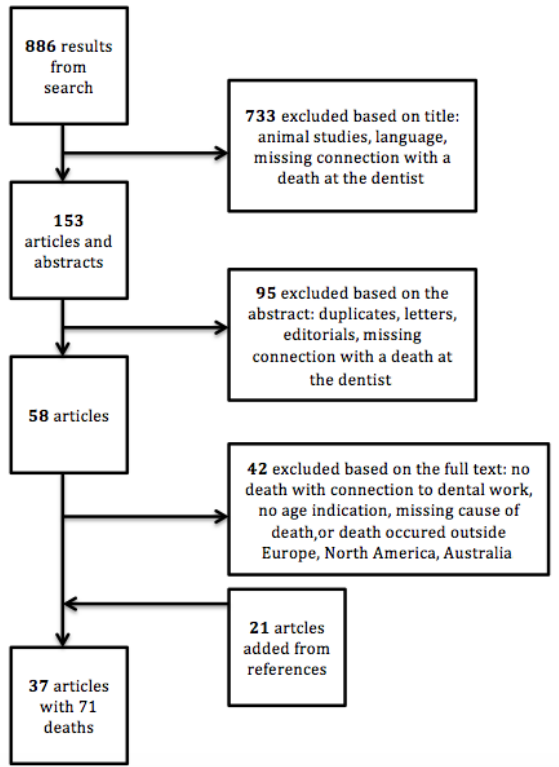
Figure 2. Flowchart for article selection from PubMed results.